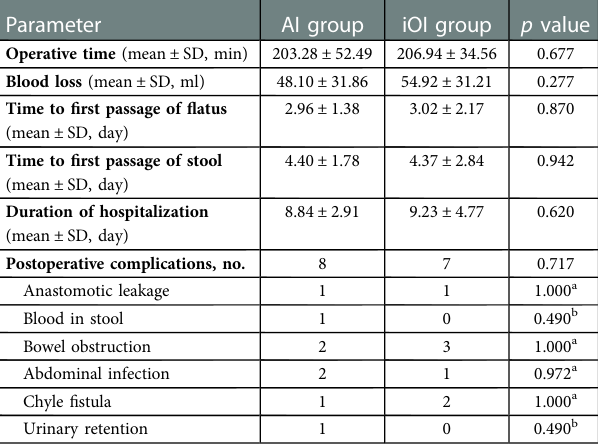
TABLE 2 Comparison of perioperative outcomes between groups.